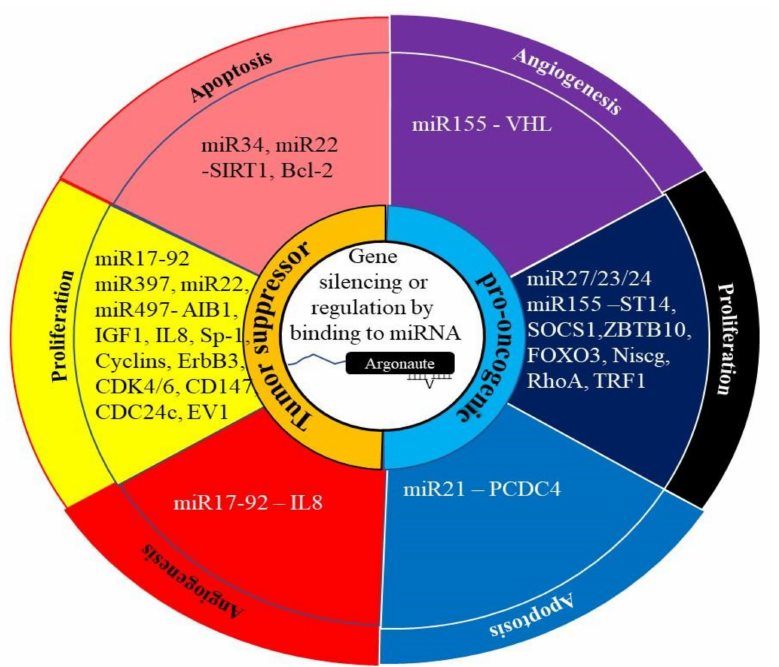
Figure 4. The role of miRNA in cancer. The regulation of gene expression by miRNAs generally involves them binding to their target mRNA and preventing or altering its translation into protein. This can be achieved through the degradation of the mRNA or altering splicing of the mRNA. In cancer, these miRNAs can act as pro-oncogenic by targeting tumor suppressor genes. Alternately, they can act as tumor suppressor miRNAs by targeting the miRNA of